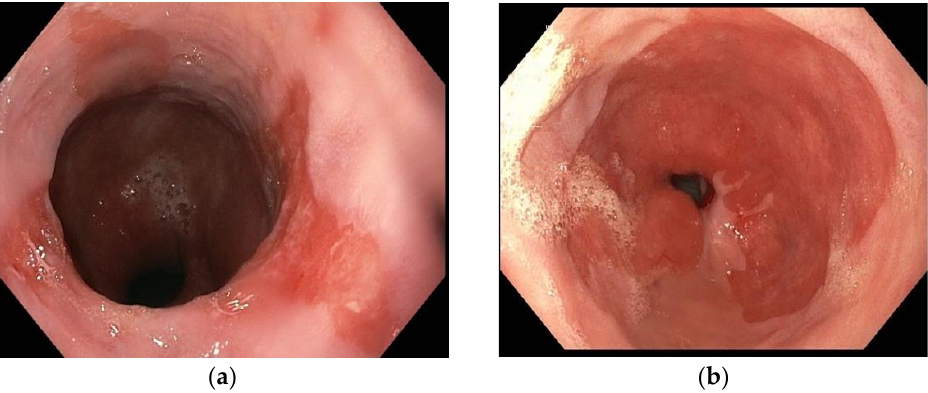
Figure 1. Gastroesophageal junction in Barrett’s Esophagus; ( a ) Segmental Barrett’s Esophagus ( b ) Circumferential Barrett’s esophagus.